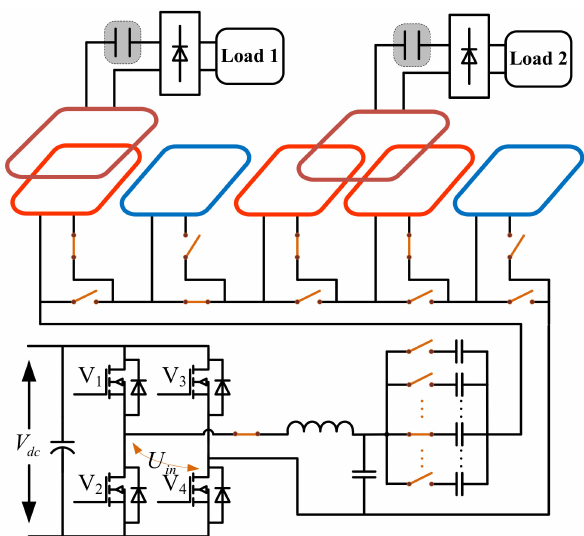
Figure 2. The structure diagram of the proposed static-dynamic hybrid wireless charging system with segmented coils for multiple